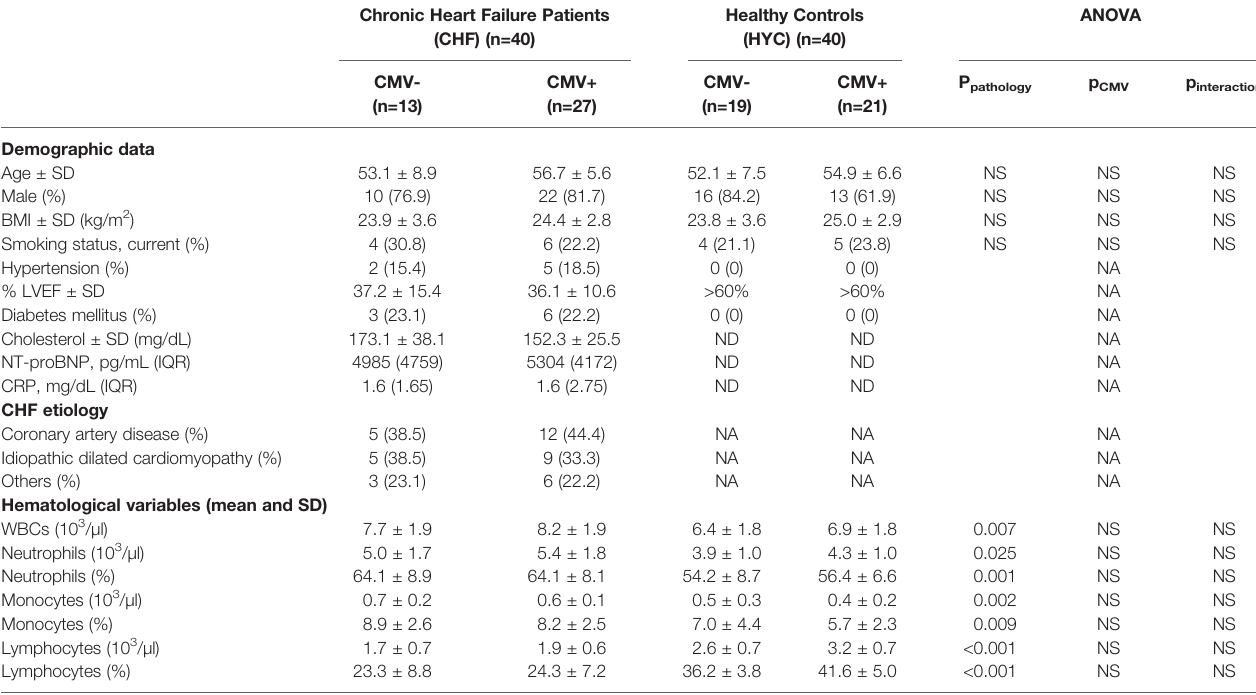
TABLE 1 | Participant characteristics in relation to CMV serostatus. Chronic Heart Failure Patients Healthy